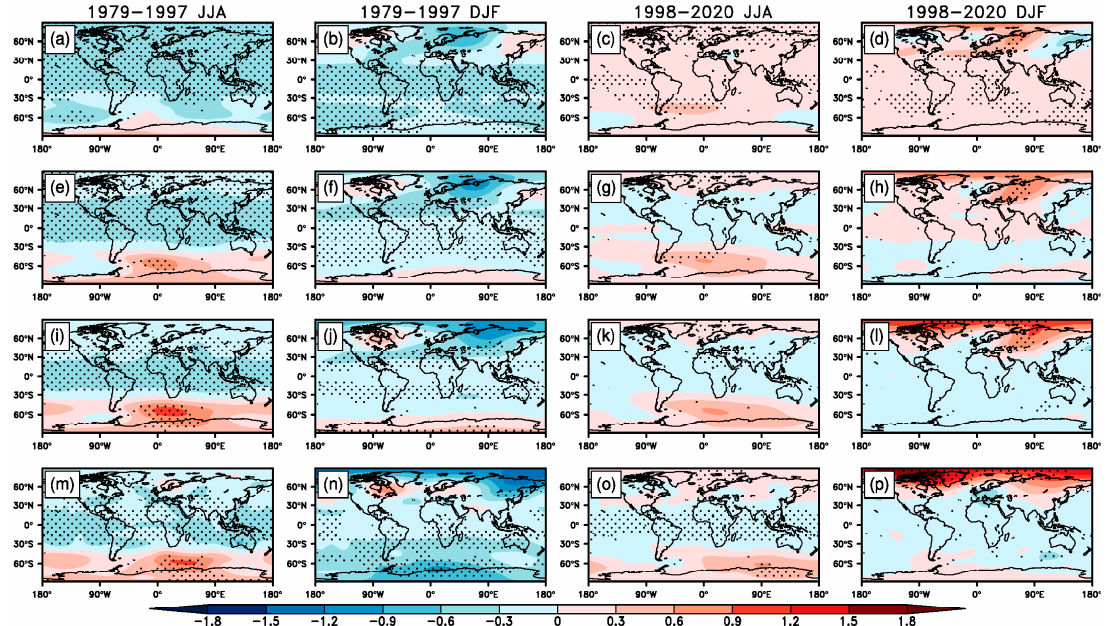
Figure 8. Geographic distributions of multi-model ensemble mean linear trends in stratospheric temperature over (left two columns) 1979–1997 and (right two columns) 1998–2020 in JJA and DJF in SSU channel ( a – d ) 3, ( e – h ) 2, ( i – l ) 1, and ( m – p ) TLS. Regions with dots are the places where trends have statistical significance levels higher than the 95% confidence level.